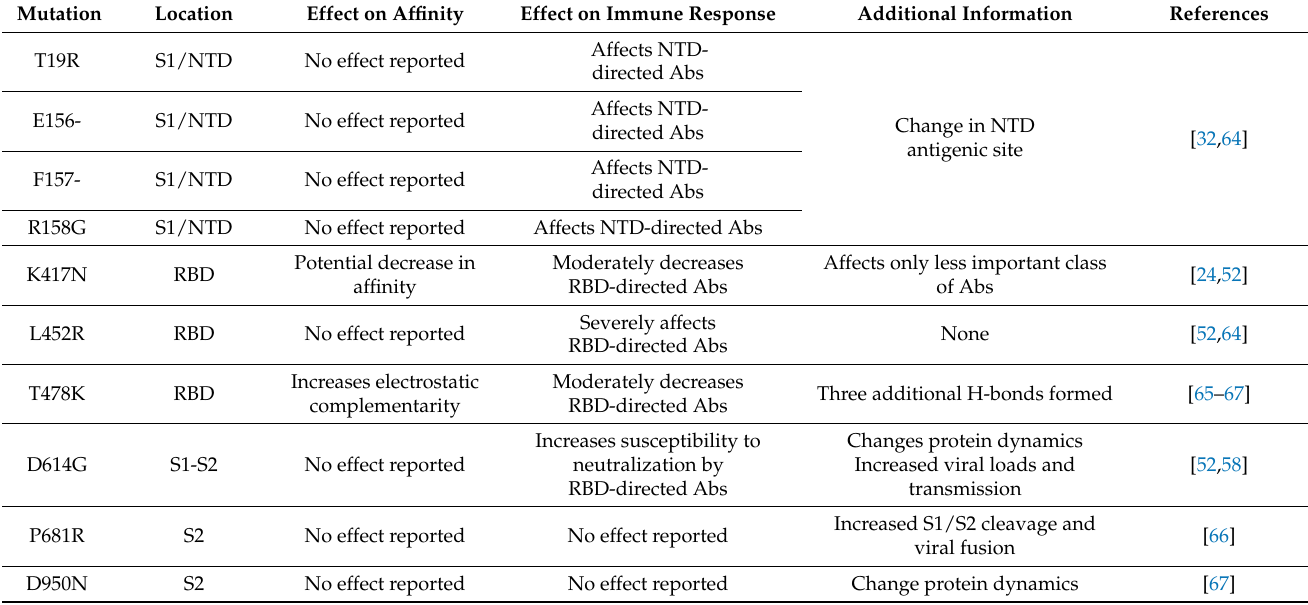
Table 2. List of mutations found in the spike protein of the Delta